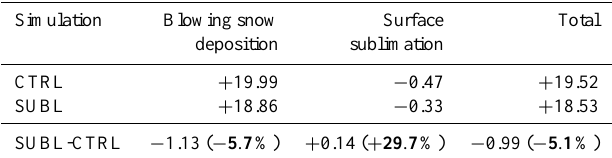
Table 5. Mass balance (inmm SWE ) of a deposition area (0.17km 2 ) located on the southern side of Col du Lac Blanc for the case study. Its location is given on Fig. 12. A positive value indicates accumu- lation. Bold values refers to relative difference in % compared to simulation